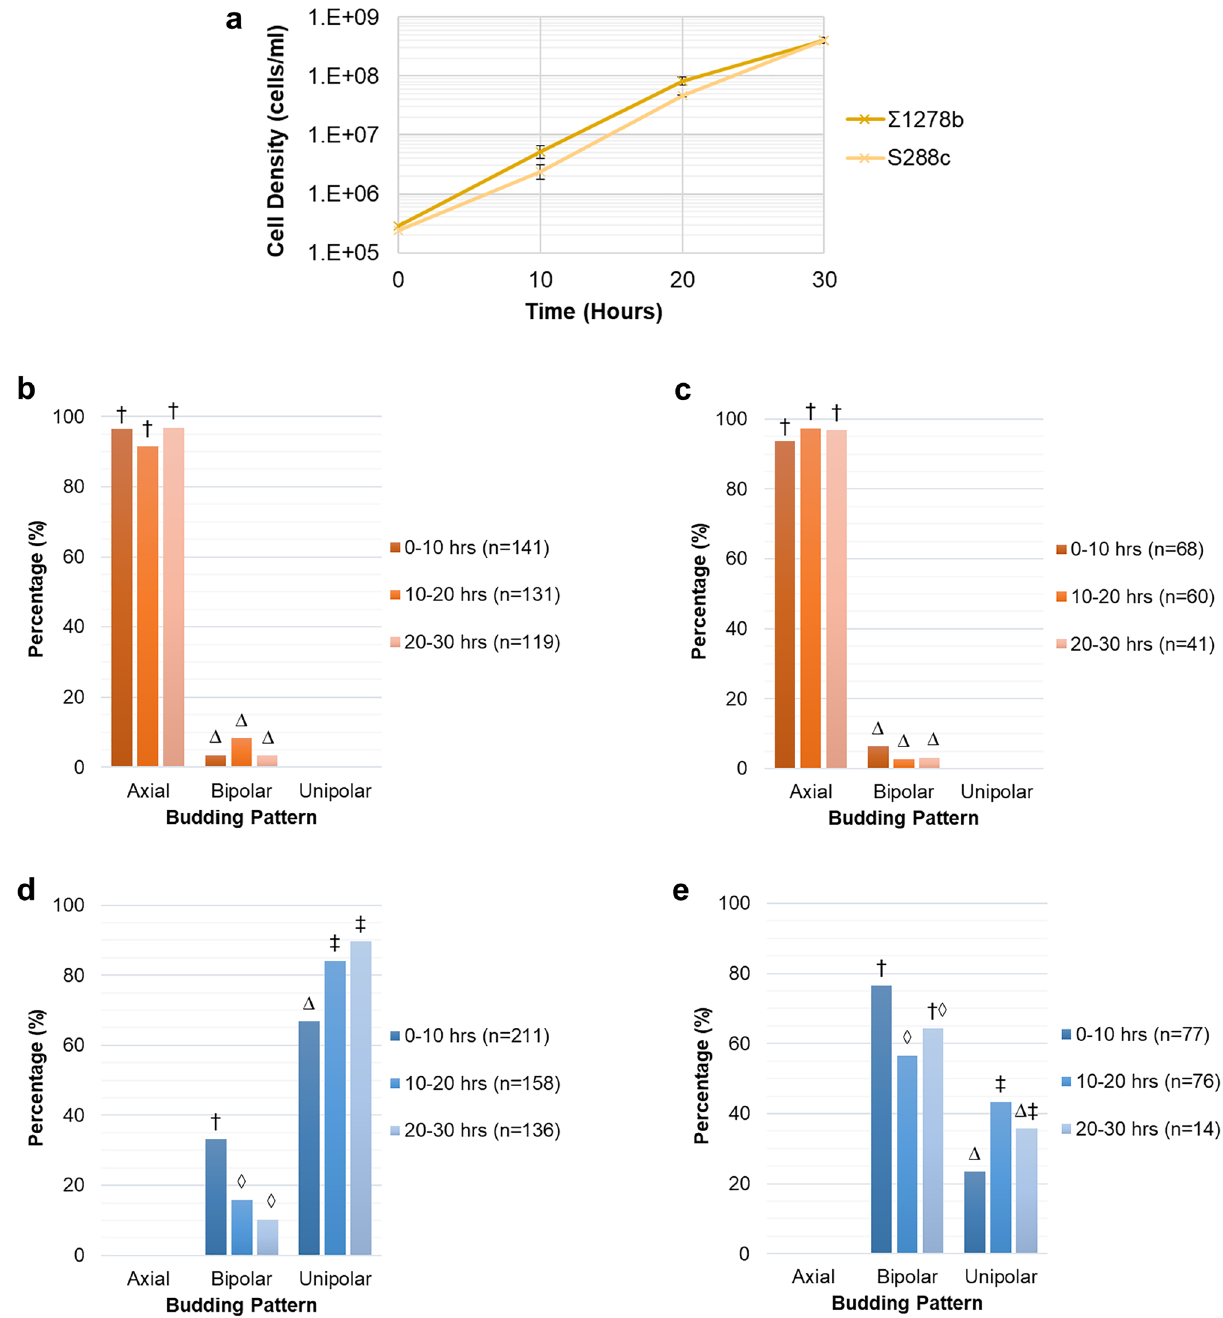
Figure 5. S. cerevisiae strains growing under high nitrogen conditions display the same budding pattern behaviour as low nitrogen conditions, with an increase in unipolar budding occurring between local cell densities of 5.2 × 10 6 and 8.2 × 10 7 cells/ml. ( a ) Change in local cell density under high nitrogen conditions measured by cell counting with a hemocytometer. Means and standard deviation for three biological replicates are shown. ( b ) Budding pattern for S288c cells with two bud sites. ( c ) Budding pattern for S288c cells with three bud sites. ( d ) Budding pattern for Σ1278b cells with two bud sites. ( e ) Budding pattern for Σ1278b cells with three bud sites. The percentage of total cells exhibiting each budding pattern are shown. Budding pattern of cells during growth were determined by manual image analysis of time-lapse images obtained using the oCelloScope™. Different symbols indicate a P value of ≤ 0.05 as determined by Fishers Exact